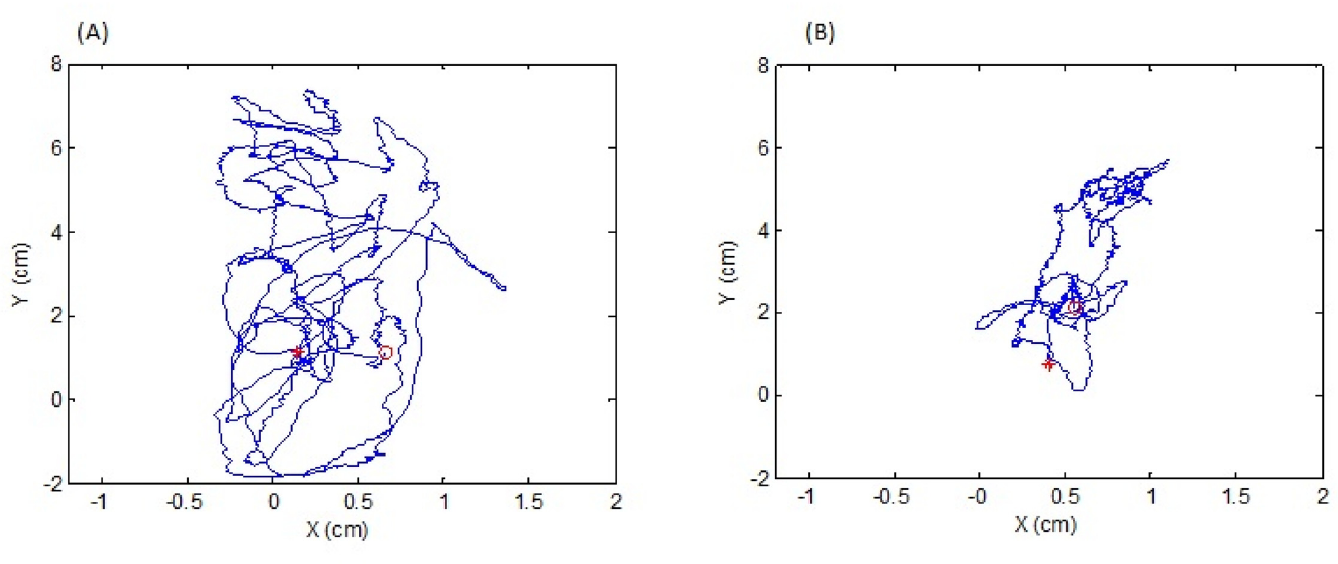
Fig 3. Excursion of the center of pressure (COP). Excursion of COP in condition 6 (A) for a patient with schizophrenia (B) for a control participant. Y-axis indicates anterior-posterior movements; X-axis indicates right-left movements.